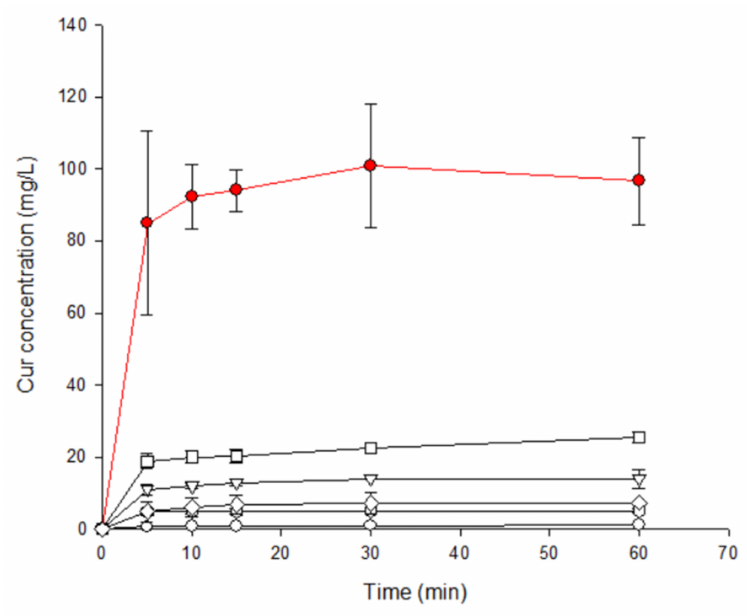
Figure 2. Dissolution rate of Cur/Epi β CD binary systems (GR ; COE ; KN ; COL ; PM ) compared with plain Cur